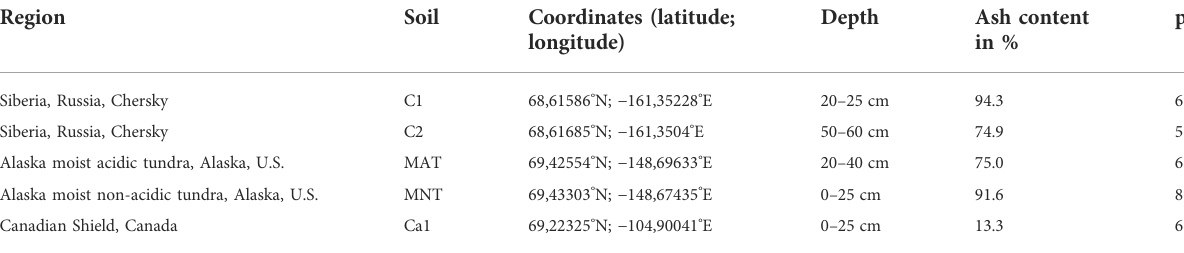
TABLE 1 Coordinates, soil sampling depth, ash content, and pH of the different soils used.